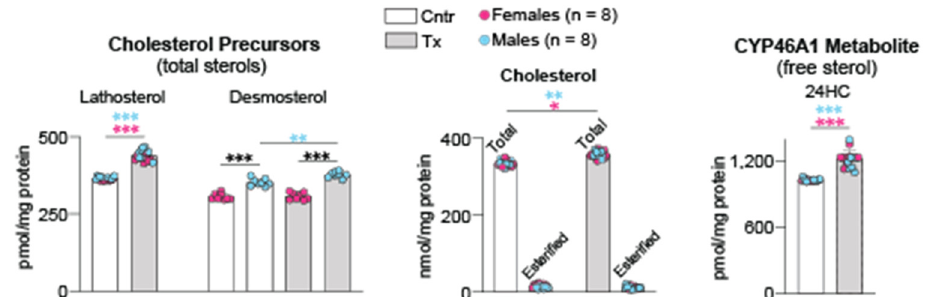
Figure 1. 8,14-DihydroxyEFV effect on sterol content in the brain. Data represent the mean ± SD of the measurements in individual 5XFAD mice (8 female and 8 male). * p ≤ 0.05; ** p ≤ 0.01; *** p ≤ 0.001 as assessed by two-way ANOVA with Tukey’s multiple comparison test. The asterisk color indicates significance between female mice (pink), male mice (blue), or male-female animals (black). Cntr, control mice; Tx, treated mice.